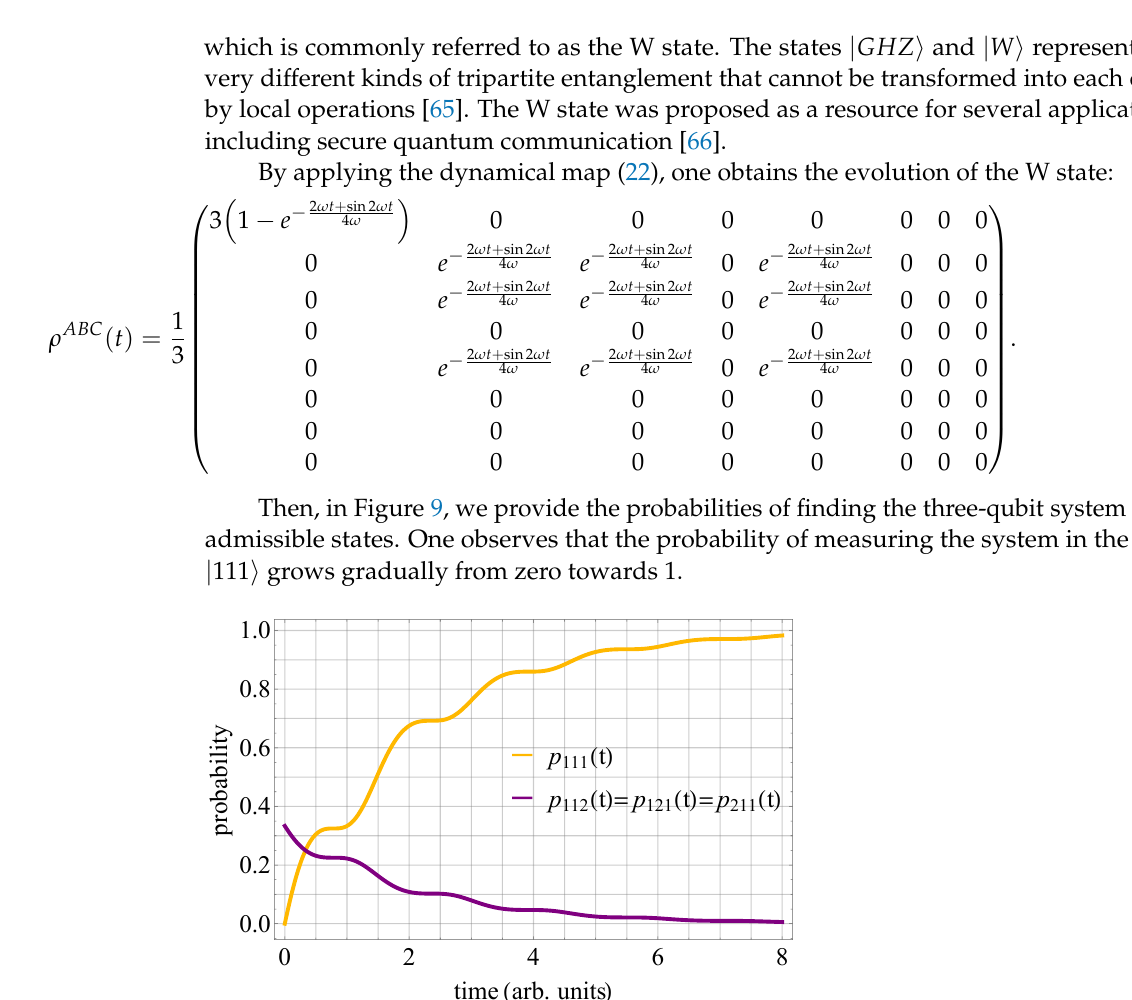
Figure 9. Plots present the probability of finding a three-qubit system in one of the possible states. The initial state is represented by (28).